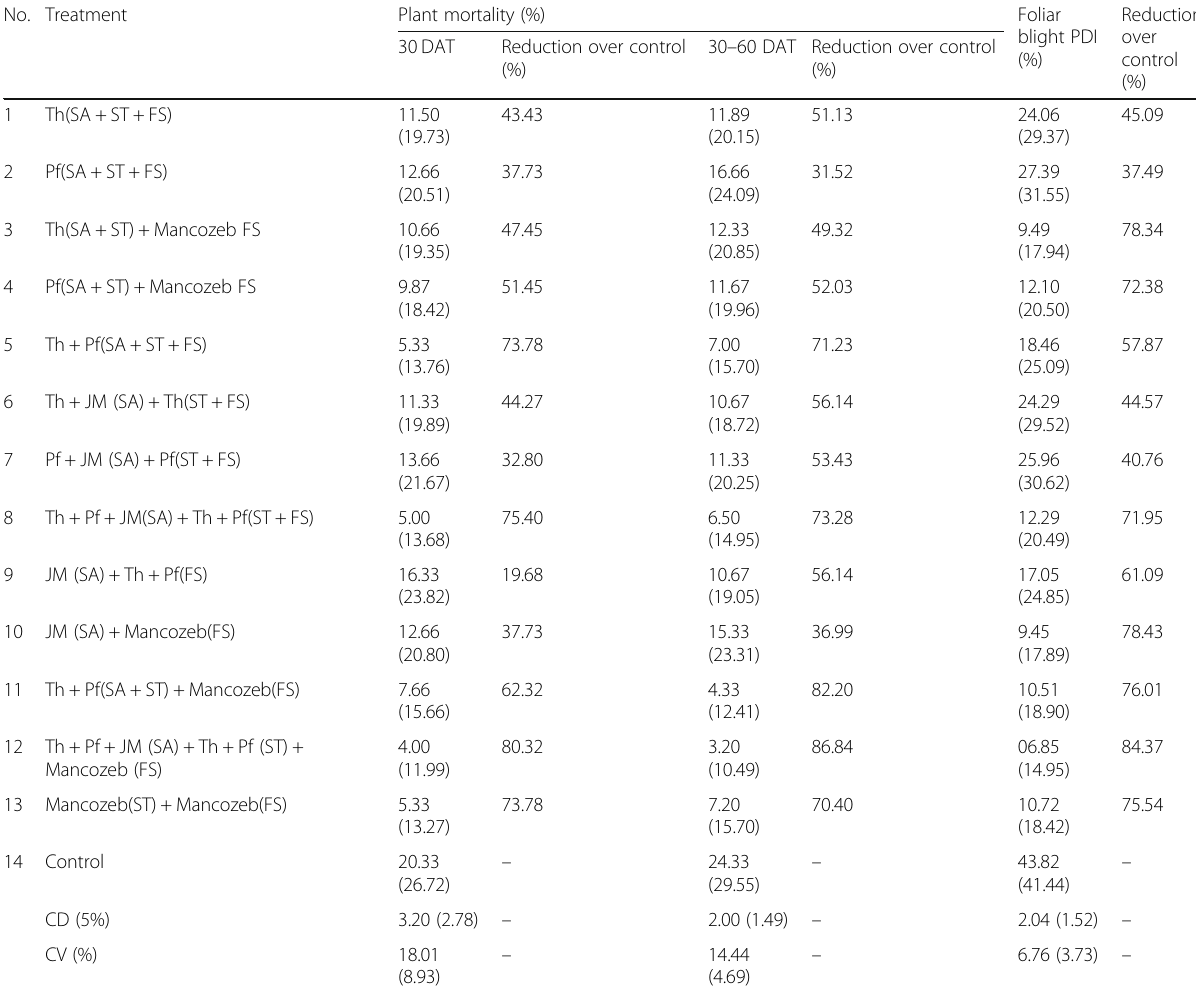
Table 3 Effect of biocontrol agents, arbuscular mycorrhizal fungi, and fungicide alone or in combinations on tomato diseases under field conditions at Vegetable Research Center during 2014 – 2015 No. Treatment Plant mortality